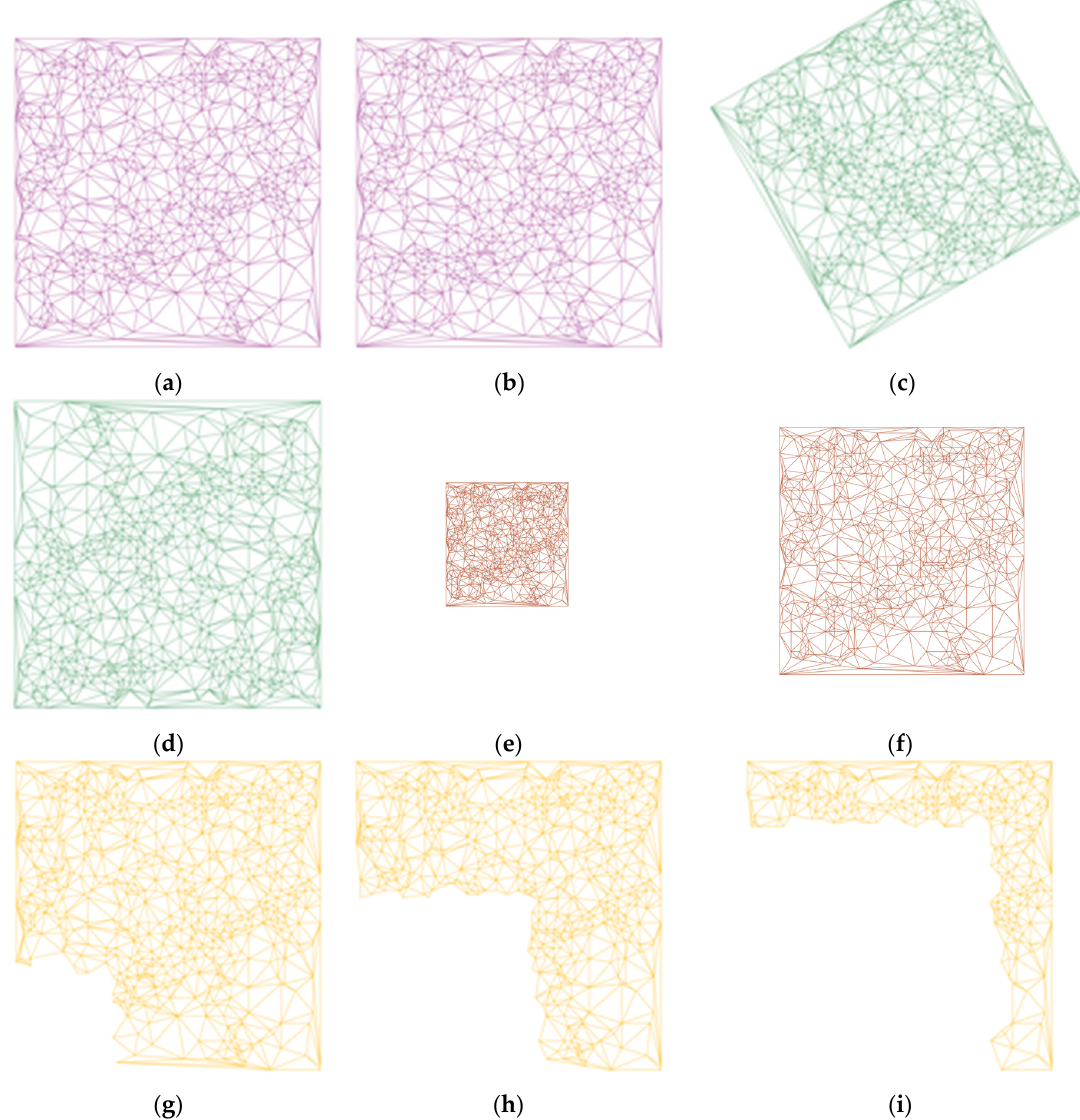
Figure 5. The data after attacks. ( a ) Translate 100 m; ( b ) Translate 600 m; ( c ) Rotate 60 ◦ ; ( d ) Rotate 180 ◦ ; ( e ) Scale 0.4; ( f ) Scale 0.8; ( g ) Crop 10%; ( h ) Crop 30%; ( i ) Crop